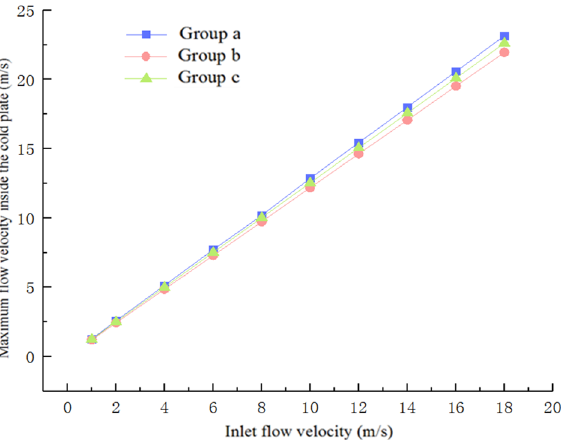
Figure 8. The relationship between the maximum flow rate and inlet flow rate of the water ‐ cooled plate with different spoiler column structures.